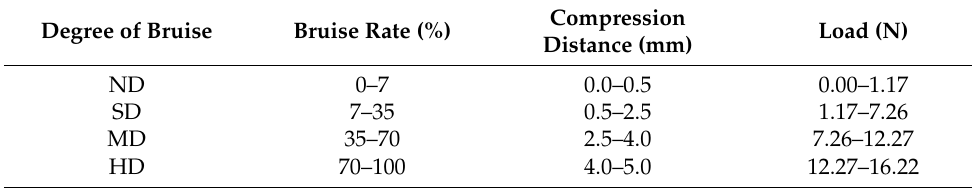
Table 2. Bruise grades for blueberries.